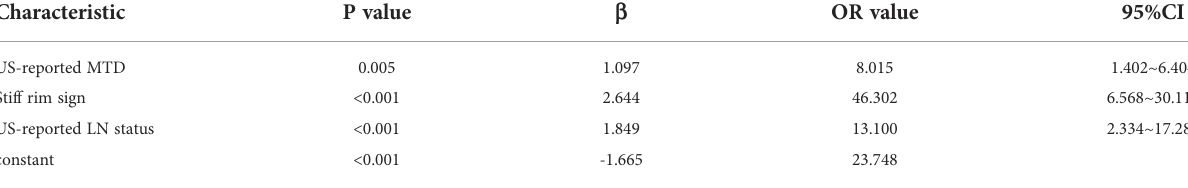
TABLE 3 Multivariate analysis of clinic-radiological characteristics in training cohort.